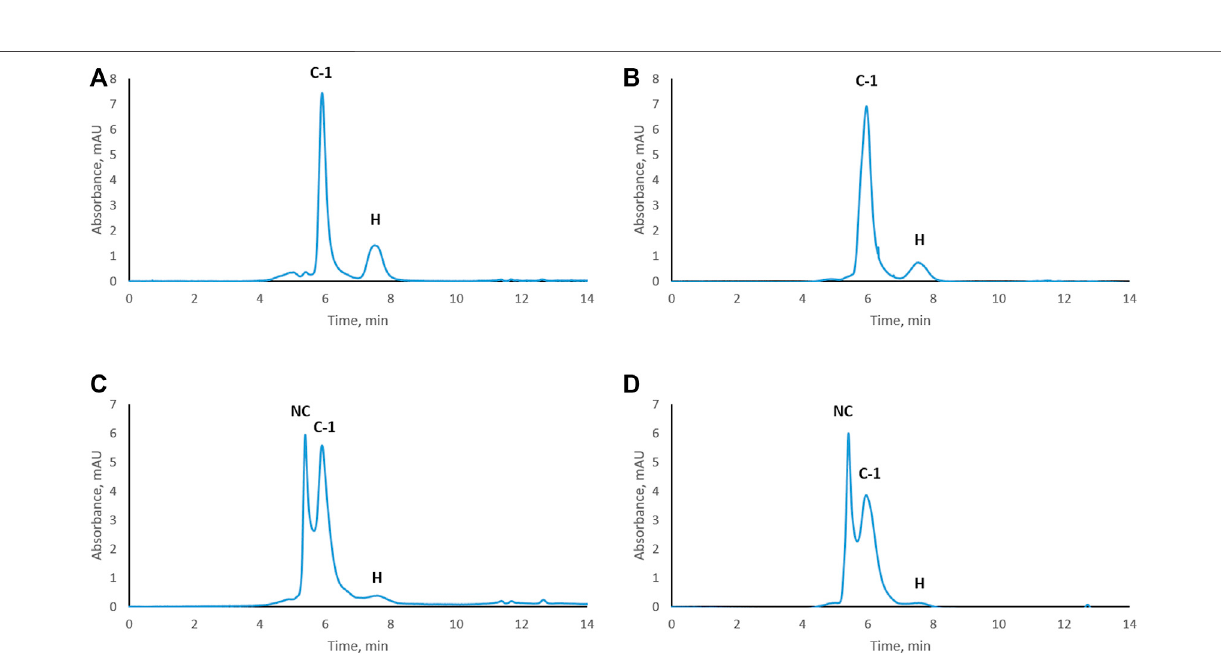
Frontiers in Chemistry |